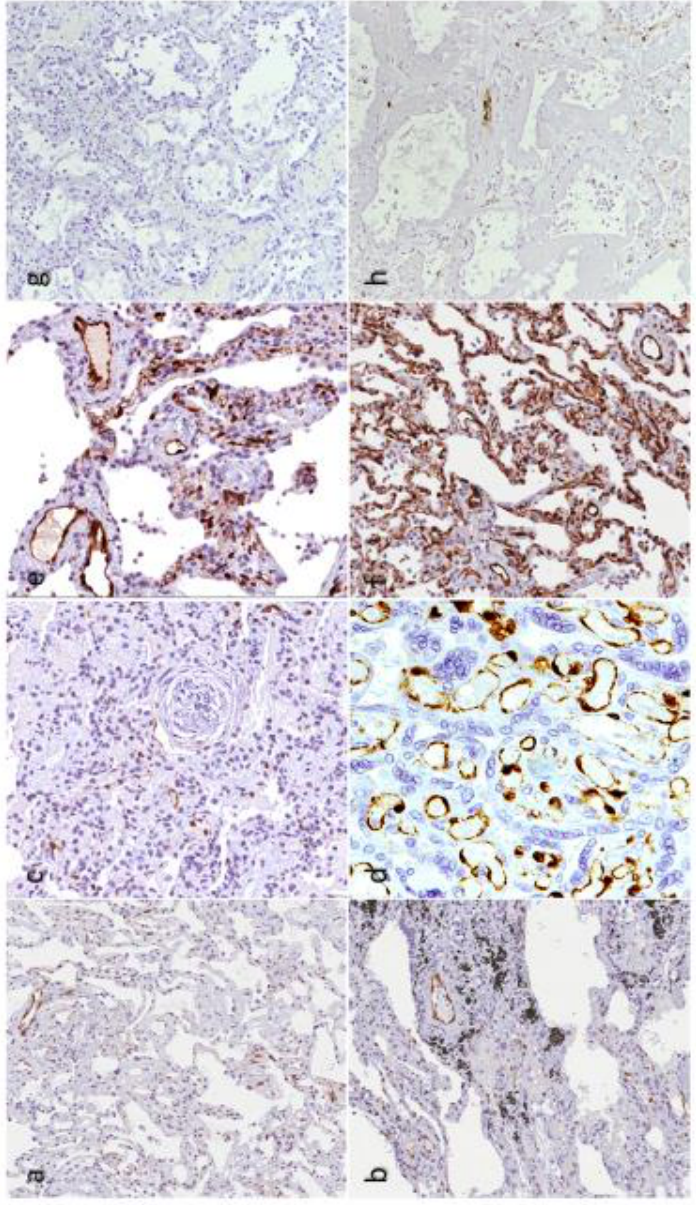
Figure 1. IDO1 endothelial expression is minimal in lung controls, where only scattered vessels are positive ( a , b ): normal lung; ( c ): organizing pneumonia. In human placenta, diffuse and strong endothelial IDO1 expression is observed in all vessels ( d ). Diffuse and strong endothelial IDO1 expression in a case of COVID-19 early/mild pneumonia ( e ). Diffuse and strong endothelial IDO1 expression in a case of post-COVID-19 pneumonia ( f ). Minimal/absent IDO1 endothelial expres- sion in two autoptic cases of severe COVID-19 ( g , h ). All cases were retrieved from the archive of Pathology Dept. of the San Raffaele Hospital, Milan, Italy and were immunostained with an-ti- IDO1 rabbit monoclonal antibody (dil.1:100, clone D5J4E, cod 86630, CellSignal, Danvers, MA, USA) with the Benchmark Ultra Instrument (Ventana-Roche). Original magnification in all images: 200 × . Matched rabbit isotype control (cod. 3900 CellSignal, Danvers, MA, USA) on the same sections was always